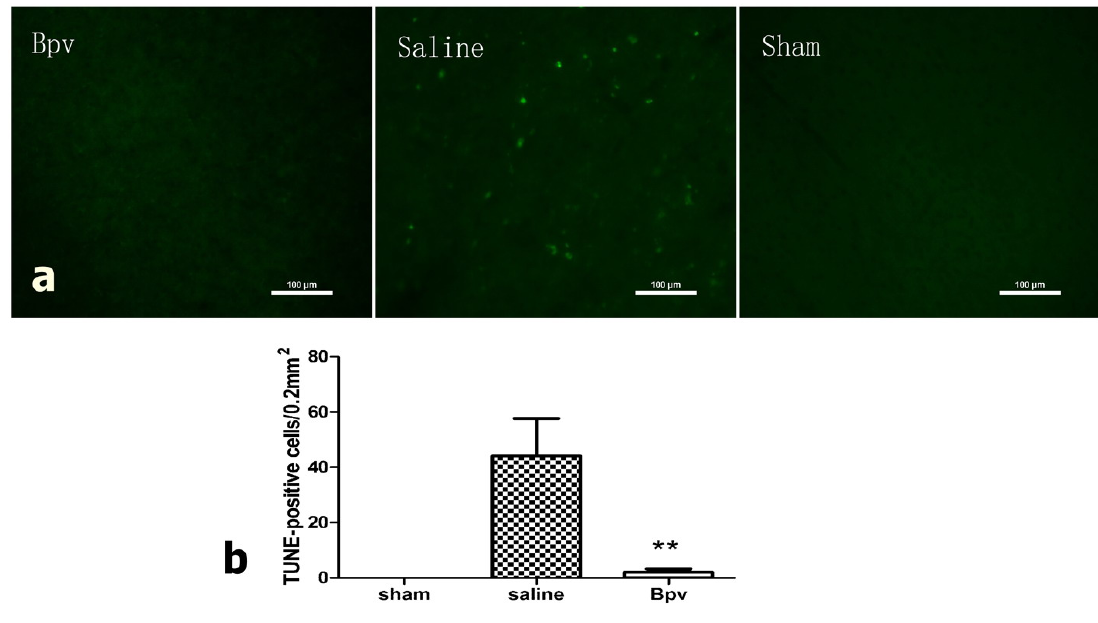
Figure 3. Bisperoxovanadium (bpV) administration blocks TUNEL-positive staining in the penumbral cortex 24 h after ischemia/reperfusion injury. ( a ) Photomicrographs of TUNEL-positive cells in the penumbral cortex. Scale bar = 100 μ m; ( b ) Bar graphs of TUNEL-positive cell counts in each group. n = 5, ** p =